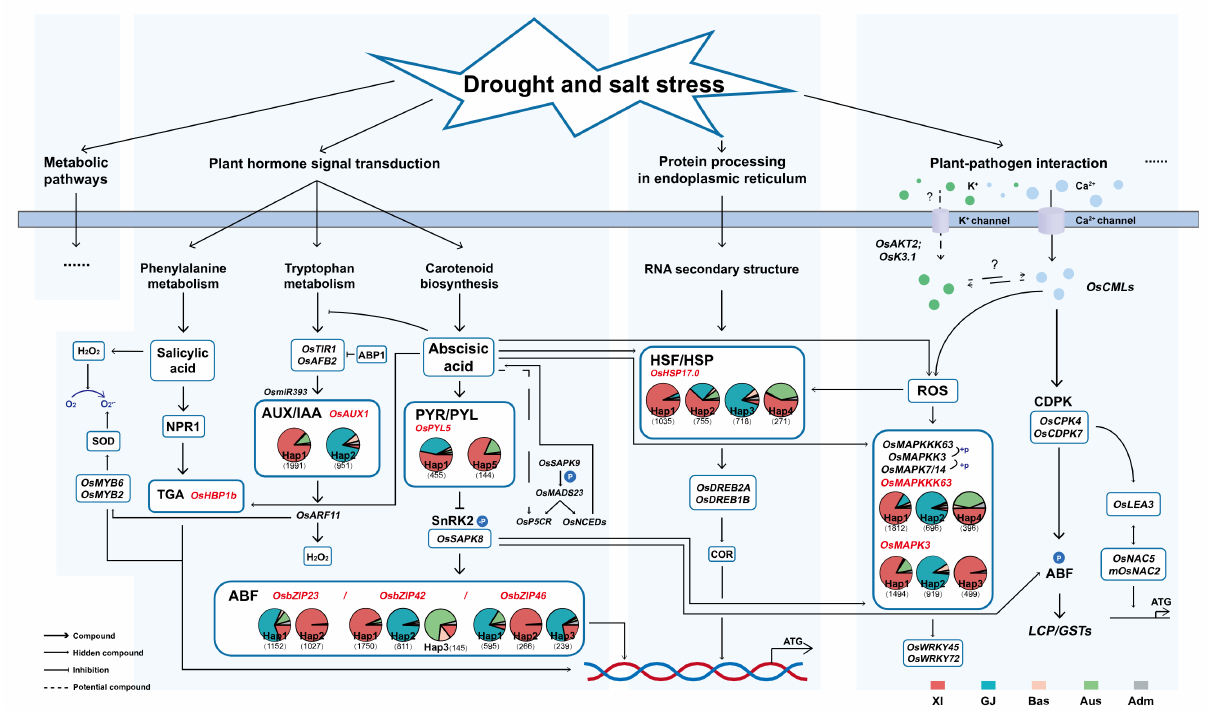
Figure 3. Dissection of gcHap-network pathway of important drought and salt co-response genes. These gene-related pathways and elite haplotypes for drought and salt co-response genes are indicated in the blue box. Firstly, OsAUX1 , OsPYL5 , and OsbZIPs (3 genes) were enriched in osa04075 that mainly included the auxin (AUX), ABA, and salicylic acid (SA) related pathways. The two rice auxin receptor genes OsTIR1 and OsAFB2 were targeted by OsmiR393 , and the MYB transcription factor MYB77 interacted with both IAA19 and ARFs. H 2 O 2 has been found to be involved in the morphogenesis of ARF. ABA occupies an important position in plant growth and plant development, and the components of the ABA signaling pathway mainly include OsPYLs , OsPP2C , OsSAPKs , and some transcription factors (TFs). Secondly, RNA secondary structure was influenced via the osa03040 or another pathway, which changed the activity and expression of HSF associated genes. Moreover, OsHSPs are associated with primary metabolism and signal transduction. Thirdly, the interaction of the Ca 2+ and ROS signaling pathways has an important role in the regulatory network of plant immunity. Component changes in the MAPK cascade pathway were influenced by the activation of the ROS pathway. The PYL-PP2C-SnRK2 core ABA-signaling module activates a MAPK cascade, which may regulate many ABA effector proteins through phosphorylation. The MAPK cascade could also be activated by the PYL-PP2C-SnRK2 core ABA signaling module, which regulates ABA-related proteins through